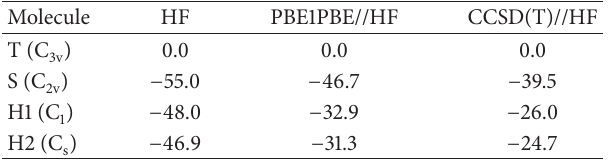
Table 2: Relative energies of N All energies are calculated with cc-pVDZ basis set. Energies are in kcal/mol. Point group symmetries of each isomer are listed with the isomer name.